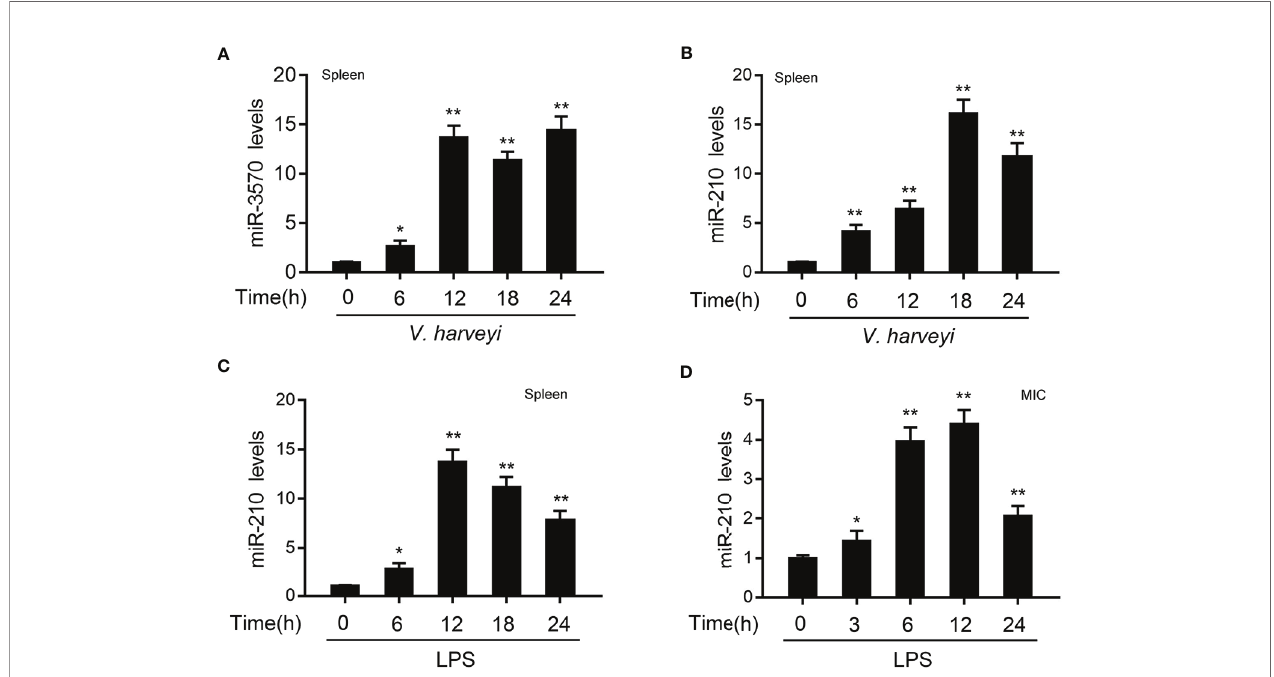
FIGURE 1 | The expression pro fi les of miR-210 and miR-3570 following V. harveyi infection. (A, B) qPCR analysis of miR-3570 (A) and miR-210 (B) expression pro fi les in miiuy croaker spleen tissues treated with V. harveyi at the indicated time points. (C, D) qPCR for the abundance of miR-210 mRNA in miiuy croaker spleen tissues (C) and MIC cells (D) after LPS stimulation at the indicated time. The miR-210 and miR-3570 expression levels were all measured by qRT-PCR and normalized to 5.8S rRNA. Results are standardized to 1 in control samples. All data are presented as the means ± SE from three independent triplicate experiments. **p < 0.01; *p < 0.05 versus the controls.